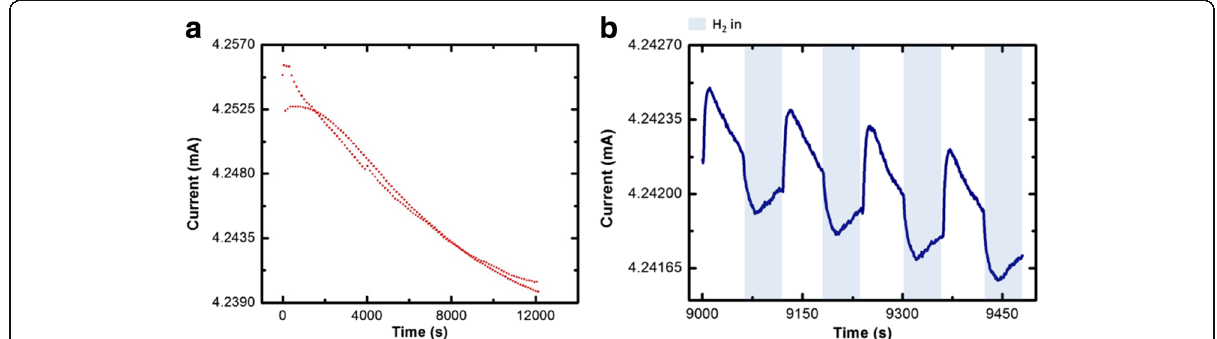
Fig. 4 Hydrogen gas sensing behaviour in the dark at room temperature. a Maximum and minimum point for 100 cycles. b Response of CuO NWs sensors toward hydrogen